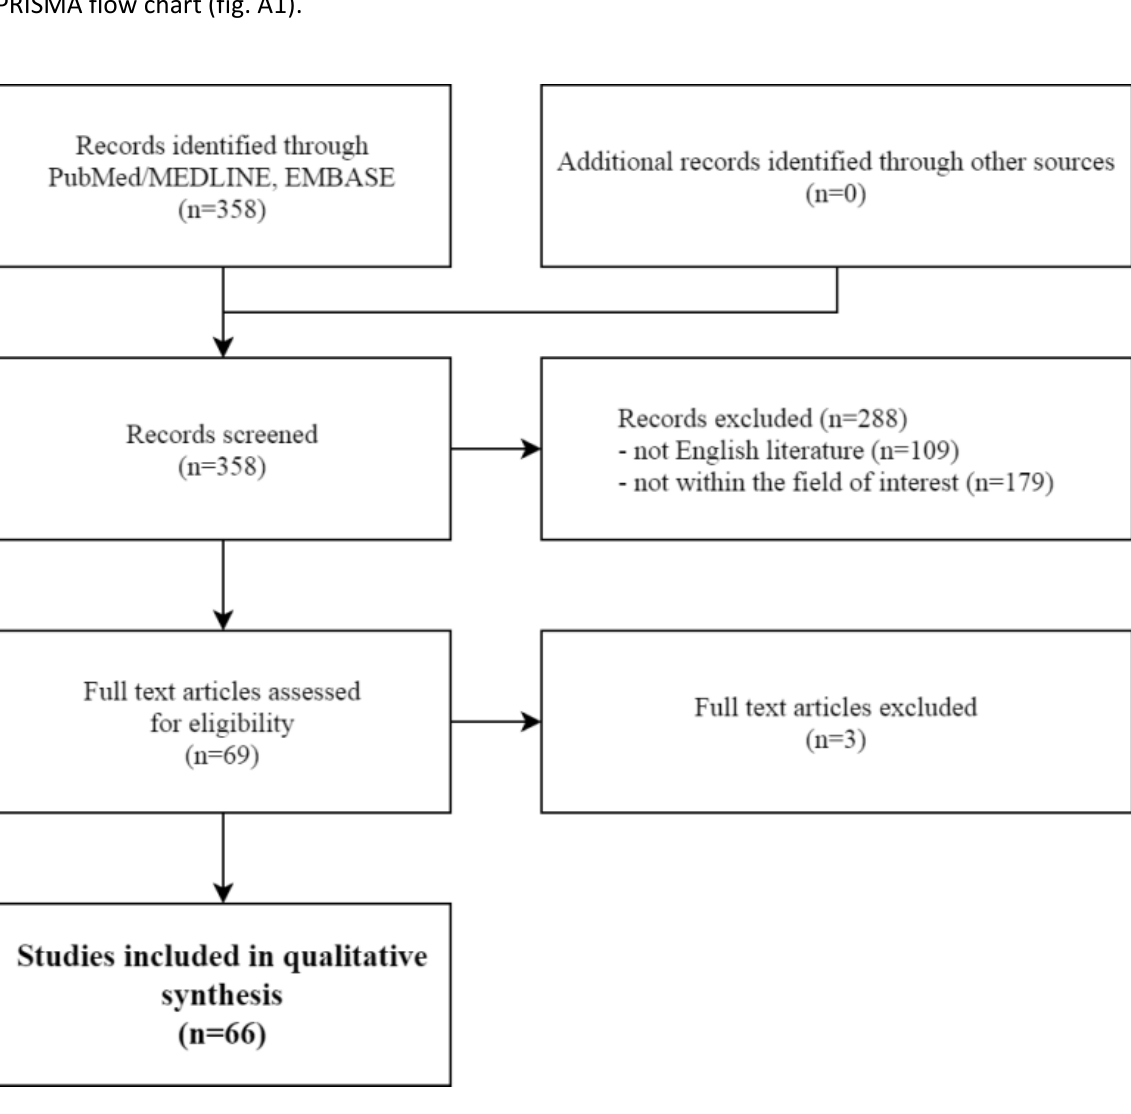
Figure A1. PRISMA flow chart of results and article sel